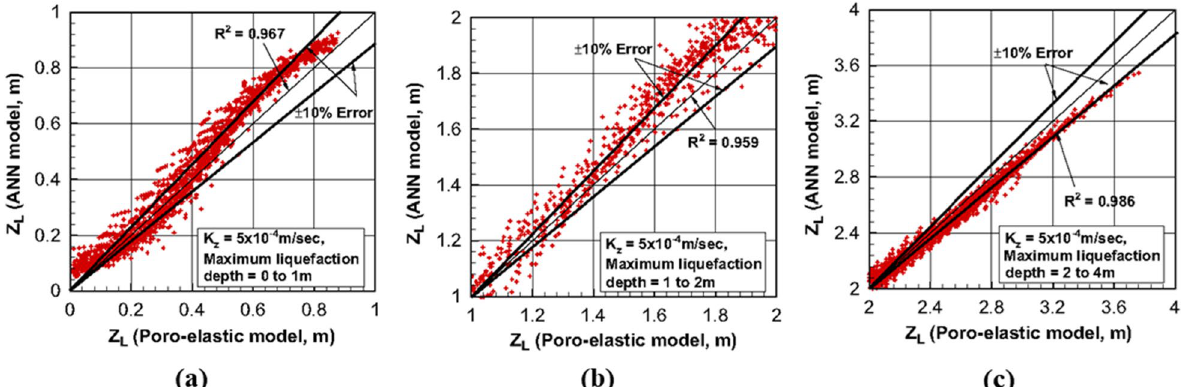
Fig. 14 Comparison of the wave-induced maximum liquefaction depths by the MANN model versus the poroelastic model, where K z = 10 − 4 m/s : a maximum liquefaction depth between 0 and 1 m, b maximum liquefaction depth between 1 and 3 m, and c maximum liquefaction depth between 3 and 5 m (modified from Cha et al. 2009; 2011)